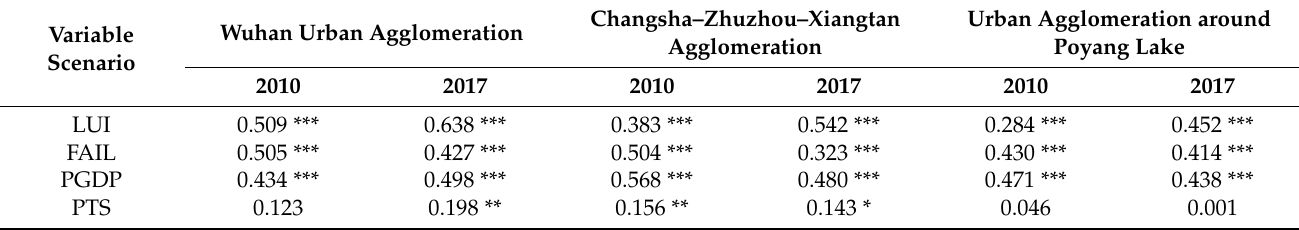
Table 3. Global Moran’s I of the Wuhan urban agglomeration, Changsha–Zhuzhou–Xiangtan agglomeration, and urban agglomeration around Poyang Lake in 2010 and